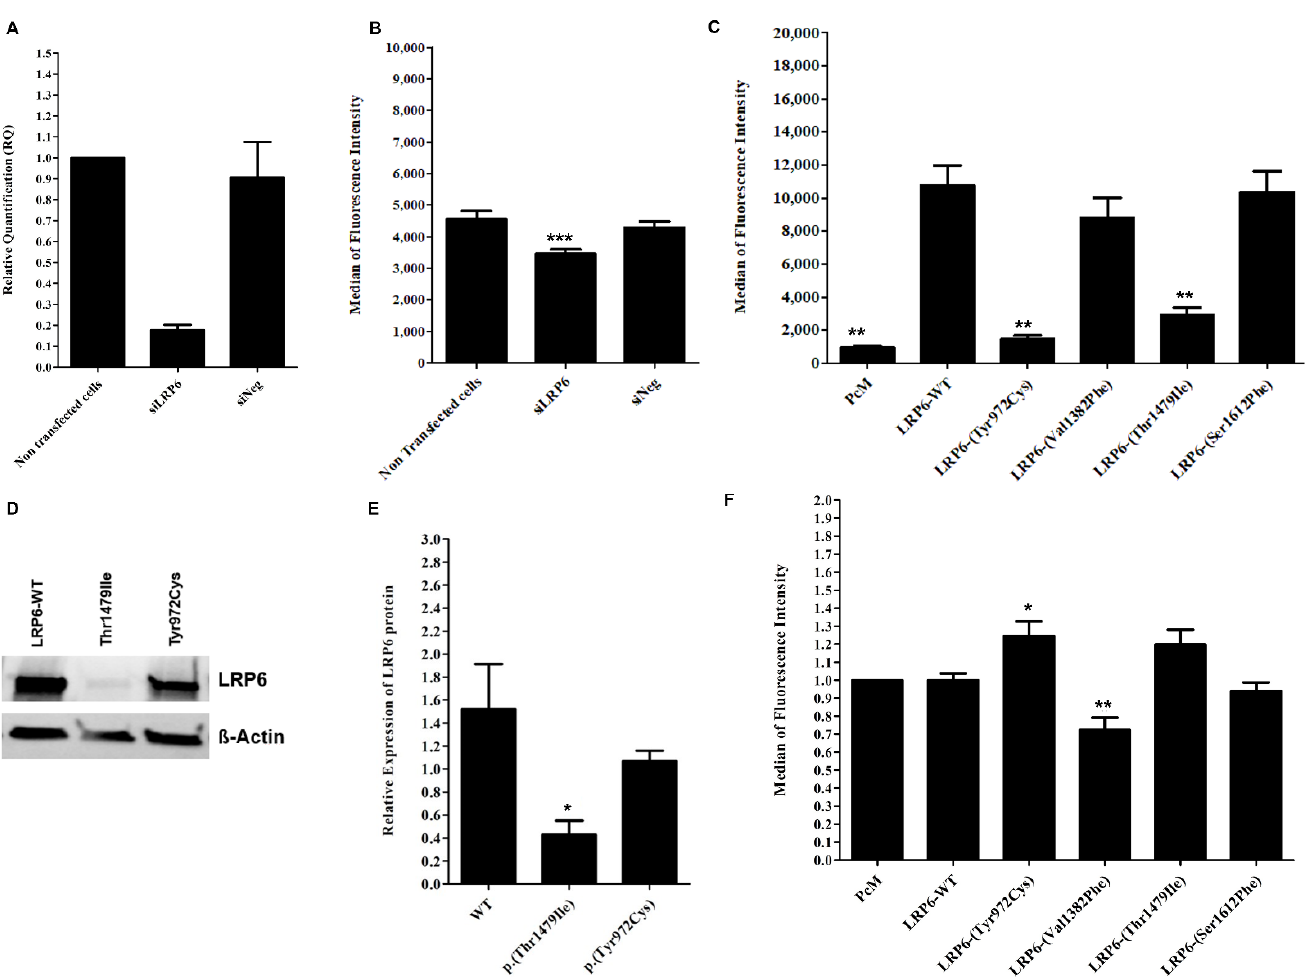
Figure 4. Effect of inhibited, overexpressed or mutated LRP6 in HEK293T and HuH7 cells . ( A ) LRP6 mRNA expression in HuH7 after the silencing of LRP6 . Reactions were run in triplicate for each cDNA. POLR2A was used as the reference housekeeping gene. The relative quantification of gene expression was performed using the ∆∆ C T method and non-transfected cells were used for calibration. ( B ) LDL-Bodipy uptake in HuH7 after silencing of LRP6 . Median fluorescence intensity of 50,000 events was acquired for each sample, but only the median fluorescence intensity of living cells is presented. Data represent three independent assays performed in triplicate. ( C ) Expression of WT or mutated LRP6 at the cell surface of transfected HEK293T . The median fluorescence intensity of 100,000 events was acquired for each sample, but only the median fluorescence intensity of living cells is presented. Data represent four independently performed assays. ( D , E ) LRP6 expression in HEK293T cells after transfection with LRP6-WT or mutated plasmid (p.(Thr1479Ile) and p.(Tyr972Cys) variants) . Proteins were extracted from transfected cells, separated by electrophoresis and then transferred onto PVDF membrane. The membrane was incubated with primary antibody (anti-LRP6), followed by incubation with secondary antibody before detection using the iBright TM FL1500 imaging system. Protein was quantified by ImageJ software. Equal loading was confirmed using the ß-actin antibody. Data represent three independent assays. ( F ) LDL uptake in HEK293T after transfection with an empty vector, LRP6- WT or mutated plasmid . The median fluorescence intensity of 100,000 events was acquired for each sample, but only the median fluorescence intensity of living cells is presented. The fluorescence of each sample was normalized using the empty vector (PcM) as a reference. Data represent three independent assays, each performed in triplicate. In all experiments, the difference between conditions was determined by Bonferroni’s Multiple Comparison Test in one-way ANOVA and * p < 0.05, ** p < 0.01, *** p < 0.001 were considered as statistically significant. Results are shown as mean ± SD. Error bars represent ± SD.